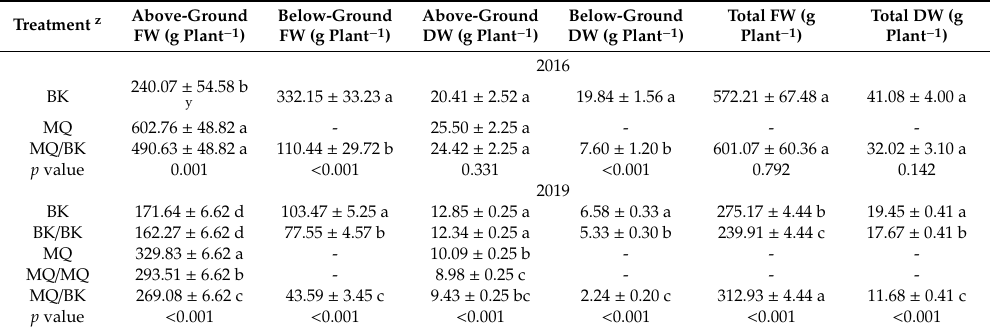
Table 4. Above-ground, below-ground, and total fresh weight (FW) and dry weight (DW) of grafted, self-grafted, and non-grafted pac choi and daikon radish plants at harvest in the 2016 pilot study and the 2019